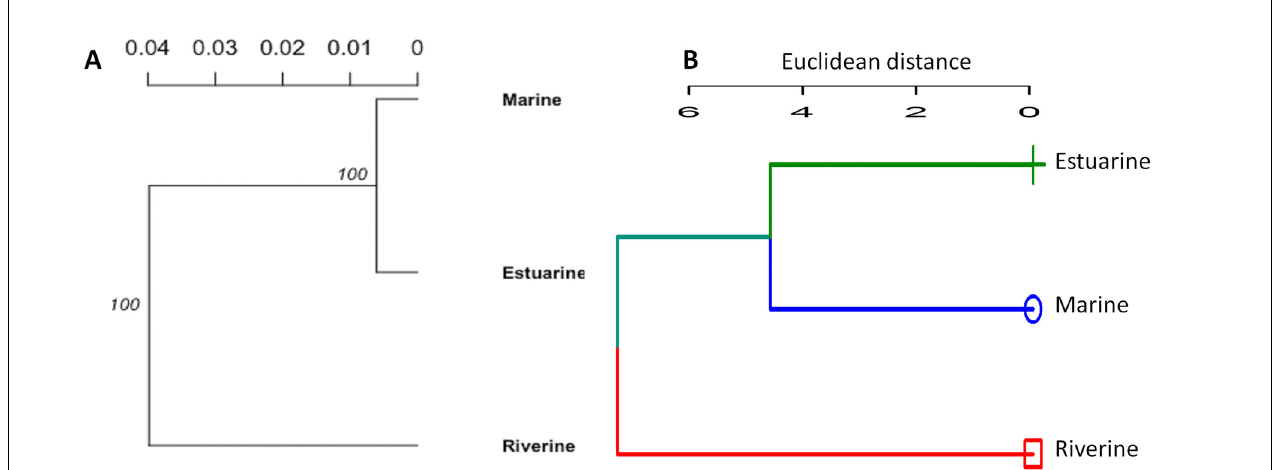
FIGURE 5 | The cluster analysis showing the morpho-genetic variation of Hilsa shad Tenualosa ilisha collected from the marine (salinity 30.3–33.4 ppt), estuarine (salinity 2.5 to 20.6 ppt) and riverine (salinity < 1.0 ppt) habitats. (A) Neighbor-joining trees, based on the Nei’s genetic distances using the 74 putatively adaptive panel of SNP loci identified by the FST OutFLANK approach. (B) Unweighted pair group method with arithmetic mean (UPGMA) dendrogram of hierarchical cluster analysis based on the Euclidean distance using the 22 truss morphometric distances of Hilsa shad population collected from their different